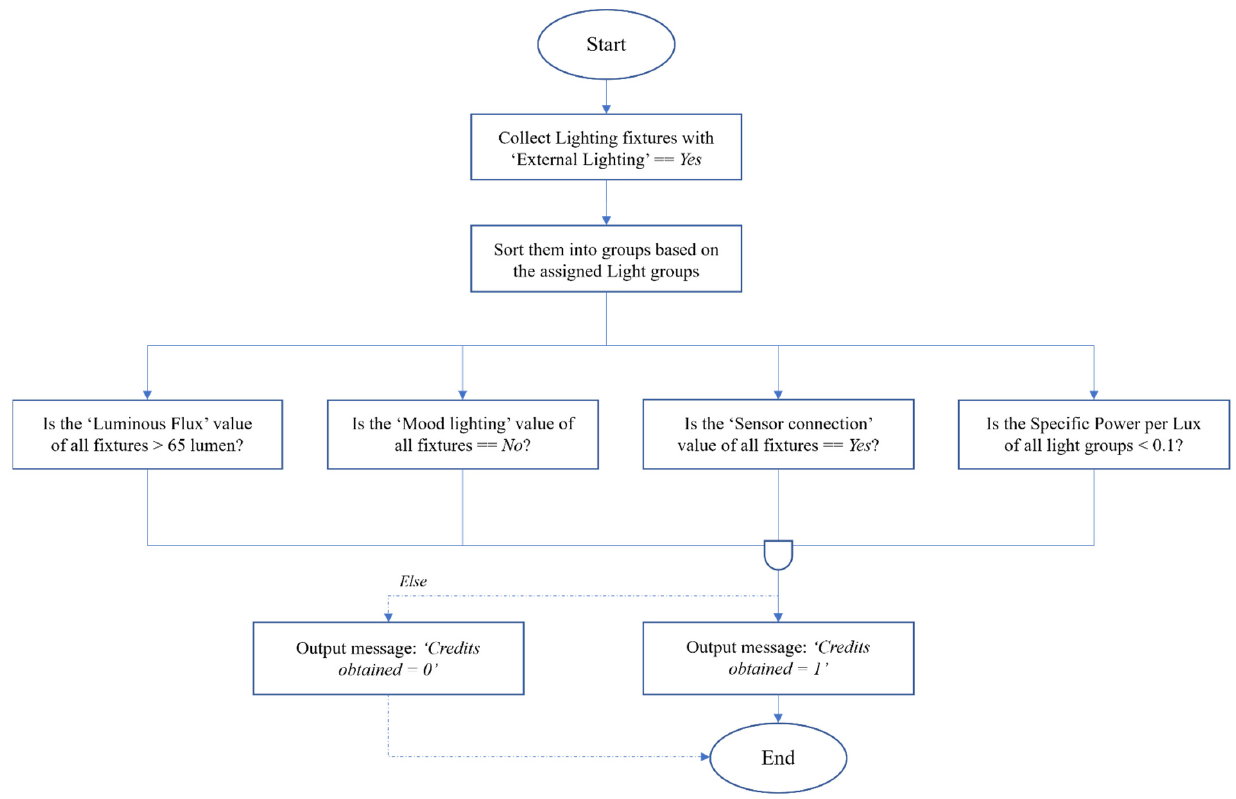
Figure 3. ENE4 plugin flowchart.